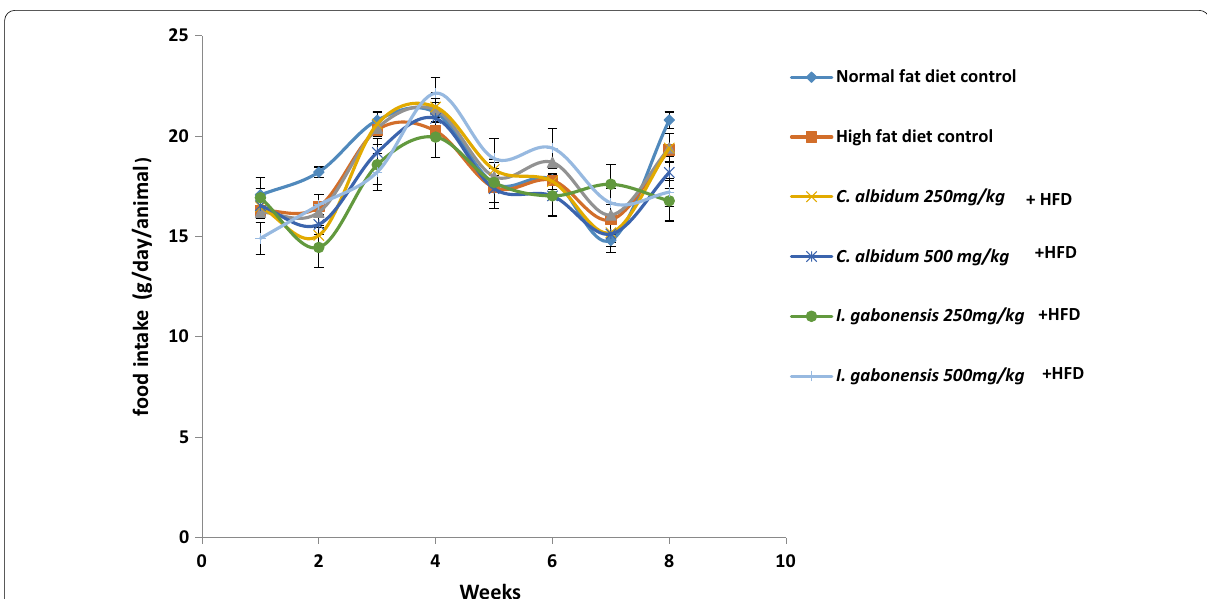
Fig. 1 Effect of methanol leaf extracts of C. albidum and I. gabonensis on feed intake of rats fed with HFD. Values are expressed as mean ( n 6). The daily food consumption of experimental rats in various groups was measured. The plant extracts did not have a significant effect on the = amount of food consumed by the rats in comparison with the NFD control and HFD control